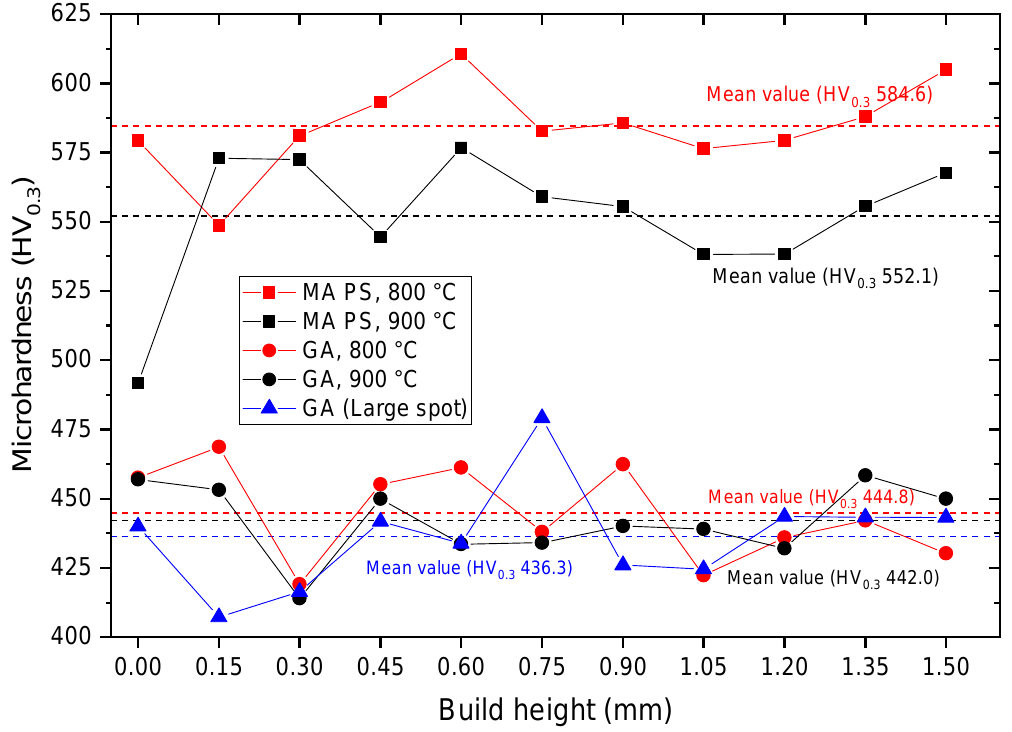
Figure 12. Microhardness variation along the build direction of the samples manufactured from MAPS powder and GA powder. The dashed lines correspond to the mean values: red—for the samples fabricated at 800 °C, black—at 900 °C, blue—using the large laser spot size.